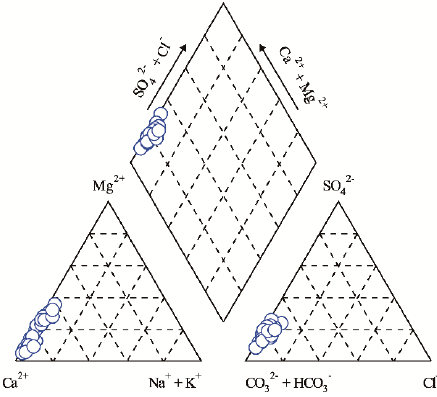
Figure 3. Piper diagram of shallow groundwater samples from karst aquifers.